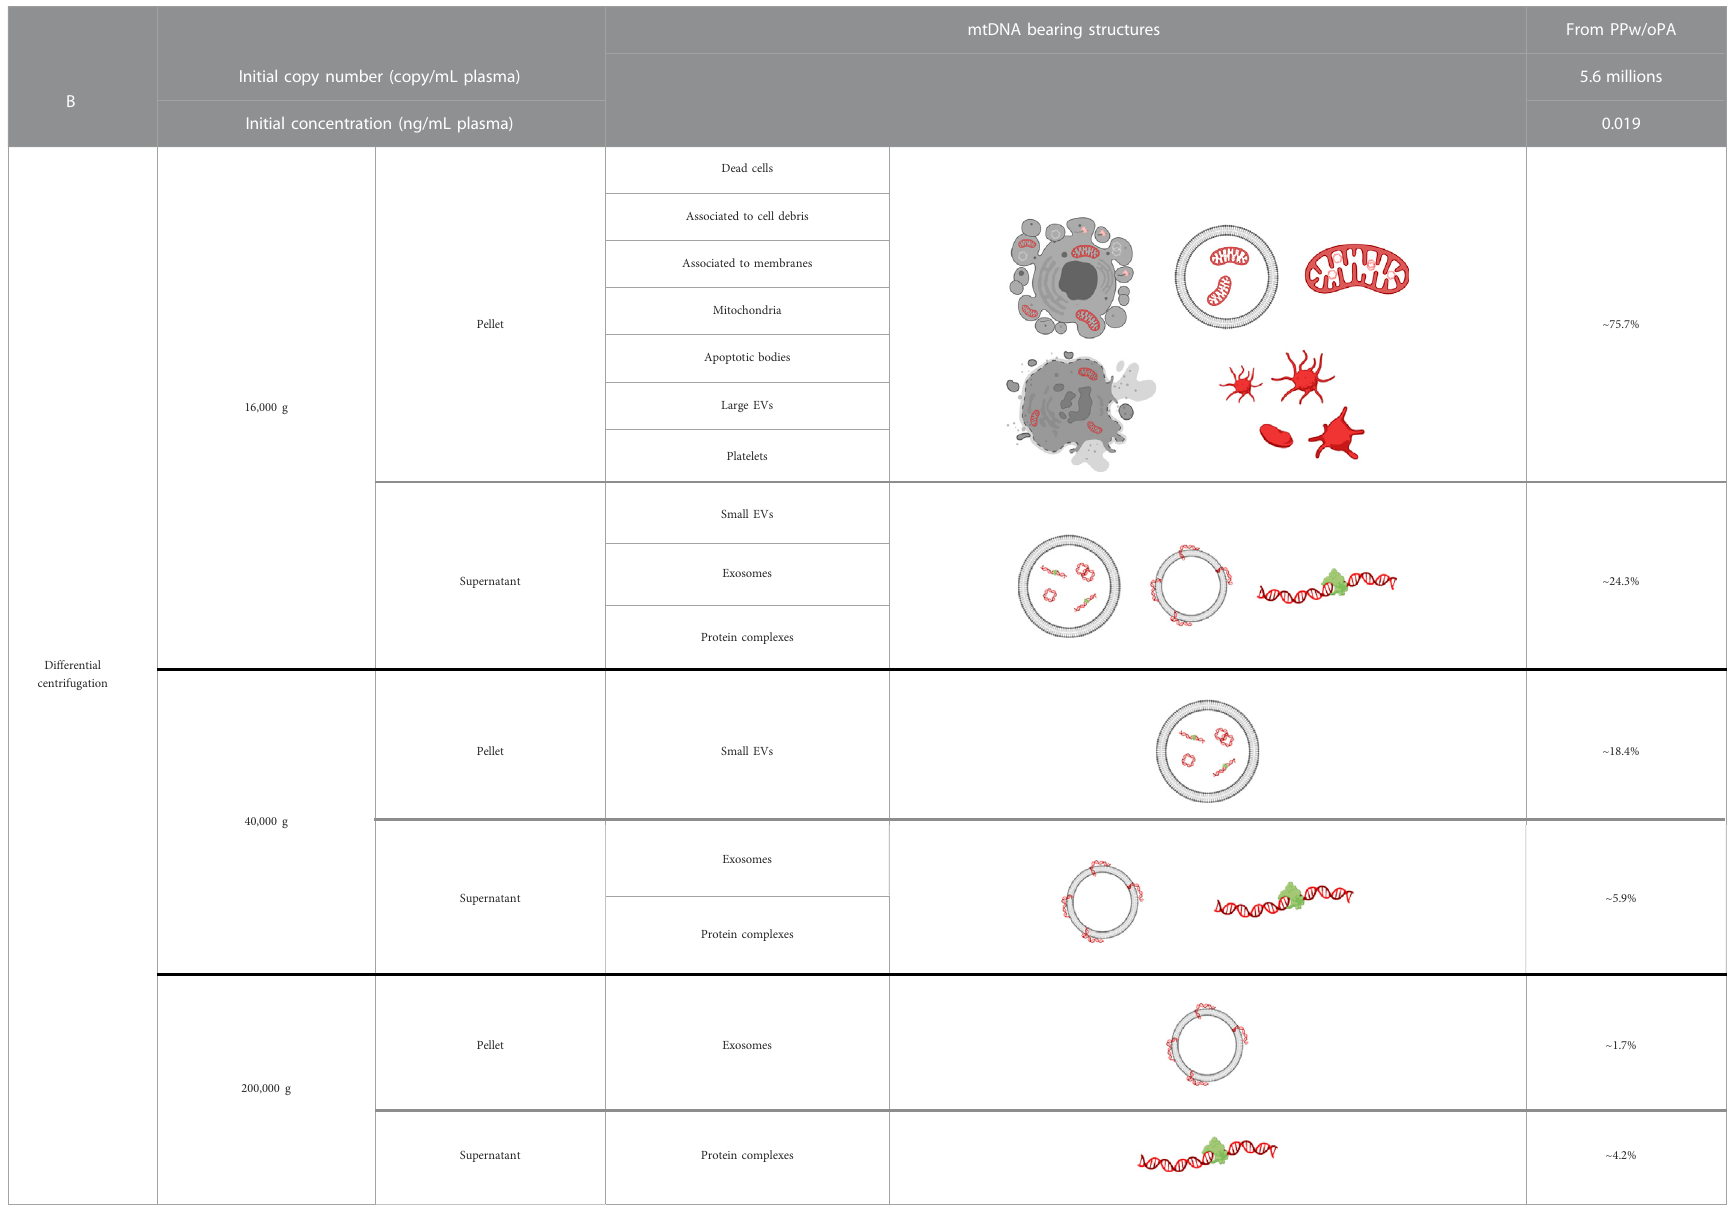
TABLE1( Continued )SuggestedrepartitionofstructurescontainingcirculatingDNA(cirDNA)inplasma.cirDNAcontentwasmeasuredinsupernatantaftersuccessivecentrifugationsatdifferentspeeds,respectively400 gwith Ficoll gradient (initial copy number); 16,000; 40,000 and 200,000 g following the preparation protocol without platelet activation (PPw/oPA). cirDNA content in the pellet was inferred from this of the supernatant at each